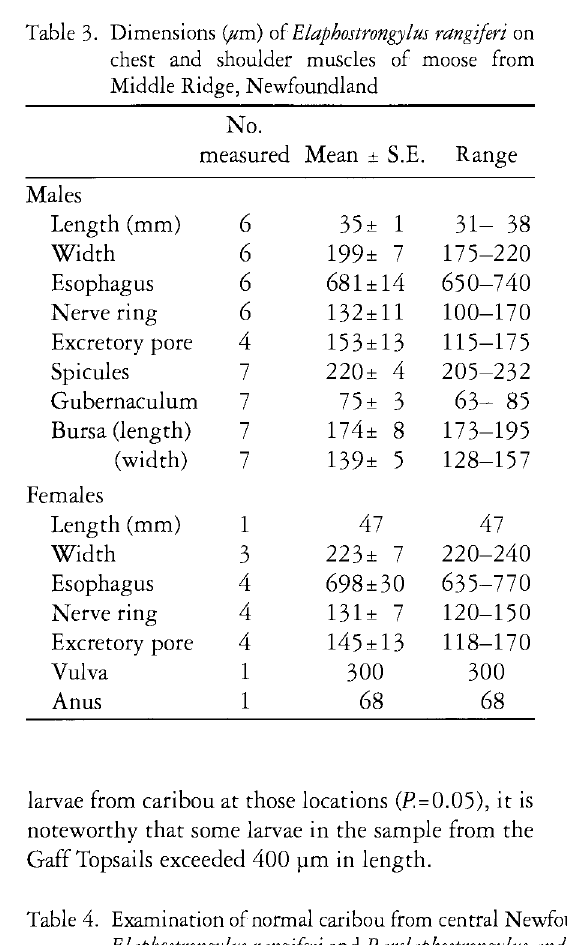
Table 4. Examination of normal caribou from central Newfoundland (Gaff Topsails) and from the Avalon Peninsula for Elapbostrongylus rangiferi and Parelaphostrongylus andersoni,